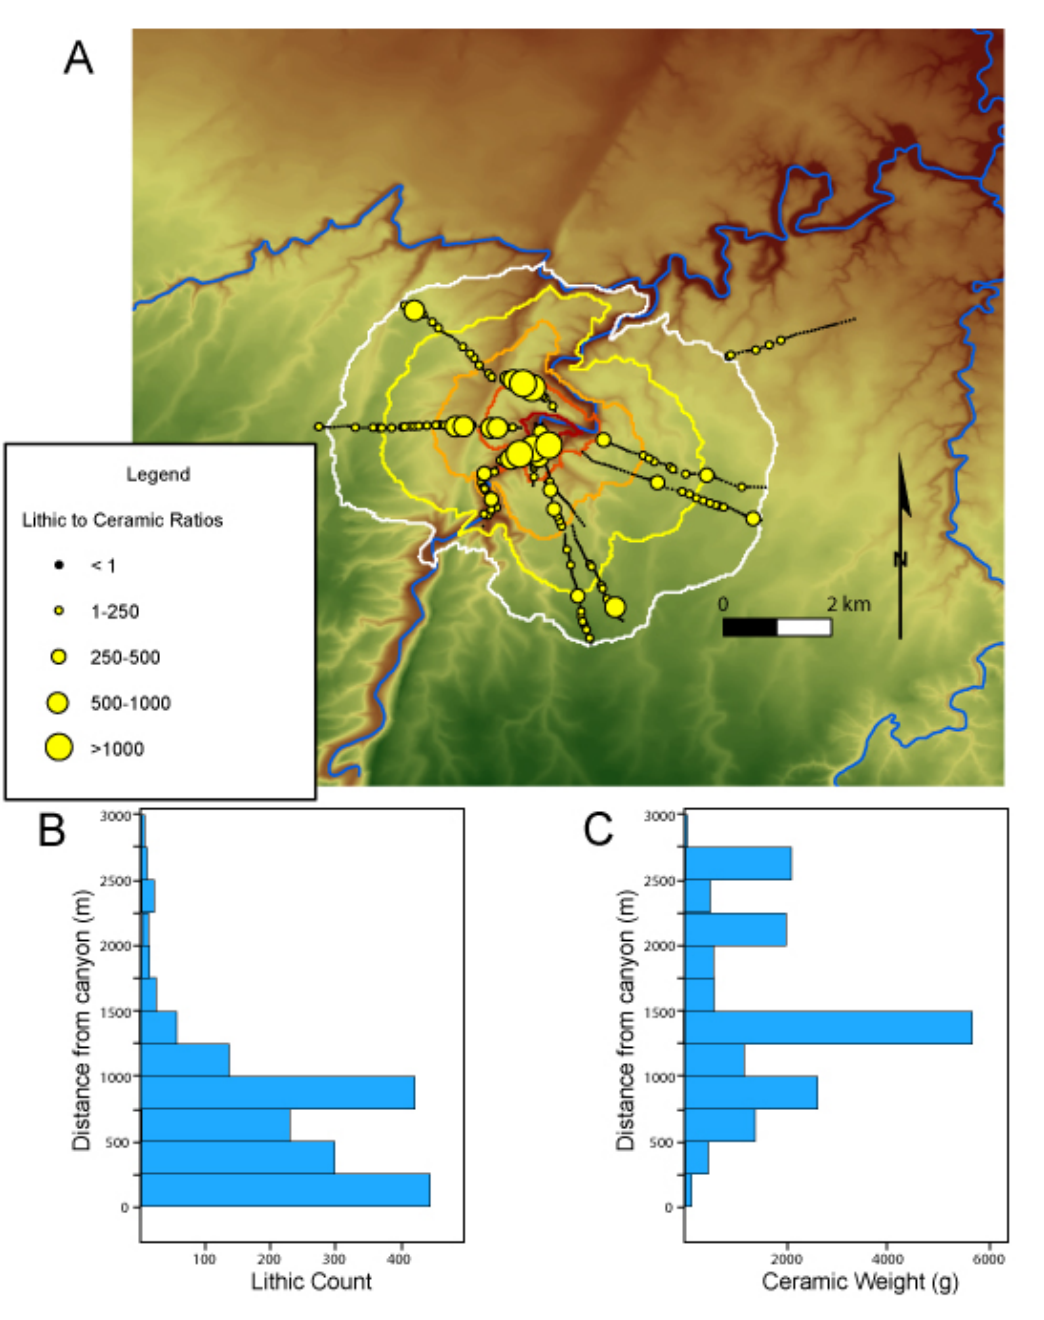
Fig. 4. (A) Lithic to ceramic weight (g) ratios for all survey patches. (B) Histogram of lithic counts against distance from the canyon. (C) Histogram of ceramic weights in grams against distance from the